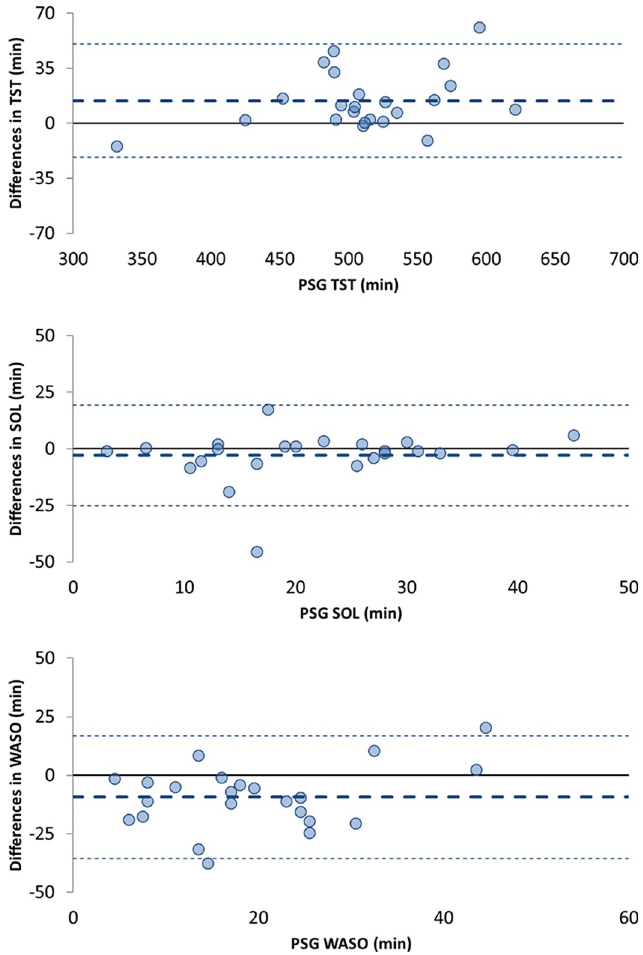
Fig 2. Bland-Altman plots for Total Sleep Time (TST), Sleep Onset Latency (SOL), and Wake After Sleep Onset (WASO). The central dotted lines represent the Bland-Altman biases; the thin dotted lines represent the Bland-Altman agreement limits. � PSG is considered the gold standard for sleep assessment, therefore, mean bias was plotted against the PSG measurement alone and not the average of measures from PSG and the Fitbit Charge